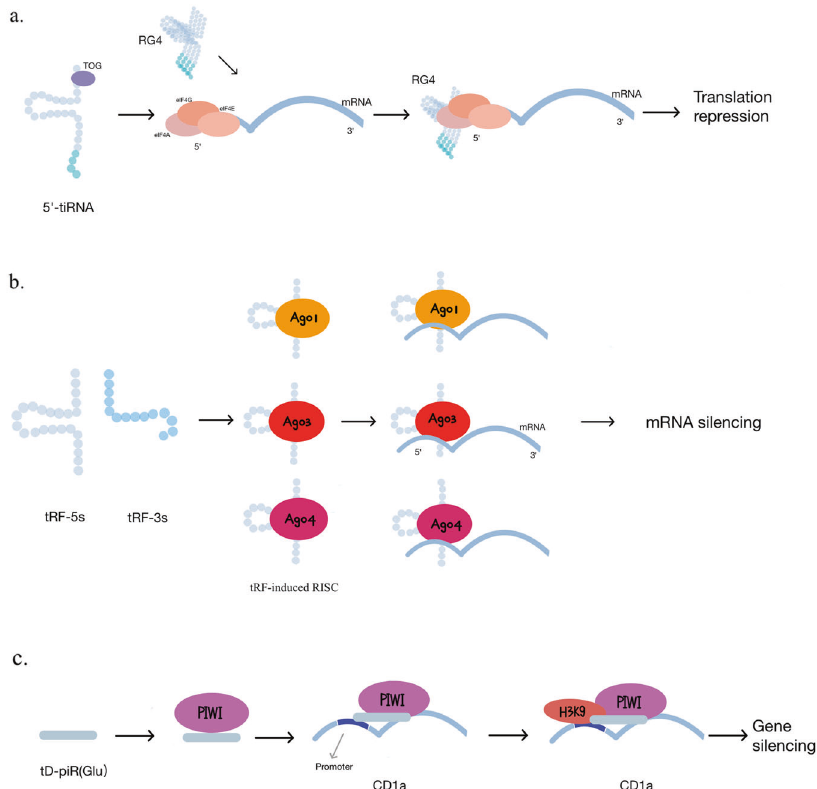
Fig. 2 Biological functions of tsRNAs. a The oligoguanine sequence at the 5 ′ terminus (TOG) of the 5 ′ -tiRNA can be assembled into an RNA G-quadruplex (RG4) structure and then leading to translation repression by replacing eIF4F complex with mRNA. b tRF-3s and tRF-5s tend to associate with Ago 1, 3, and 4 and form tRF-induced RISCs. They target the coding region, 3 ′ UTRs and 5 ′ UTRs of mRNA. c tD-piR (Glu) can bind the PIWIL4 protein to form a complex and then recruit H3K9 methyltransferases to the CD1a (a speci fi c and functional marker of DCs) promoter region. Highly expressed td-piR(Glu) inhibits CD1a transcription in Base modi fi cation is one of the vital determinants of the biogenesis and function of tsRNAs. The cytosine-5 RNA methyl- transferase NSUN2 is highly expressed in epithelial tumors. The loss of cytosine-5 RNA methylation (m5c) due to NSUN2 de fi ciency promotes the ANG-induced cleavage of tRNA and leads to an accumulation of 5 ′ -tRNA halves. Meanwhile, the accumulated